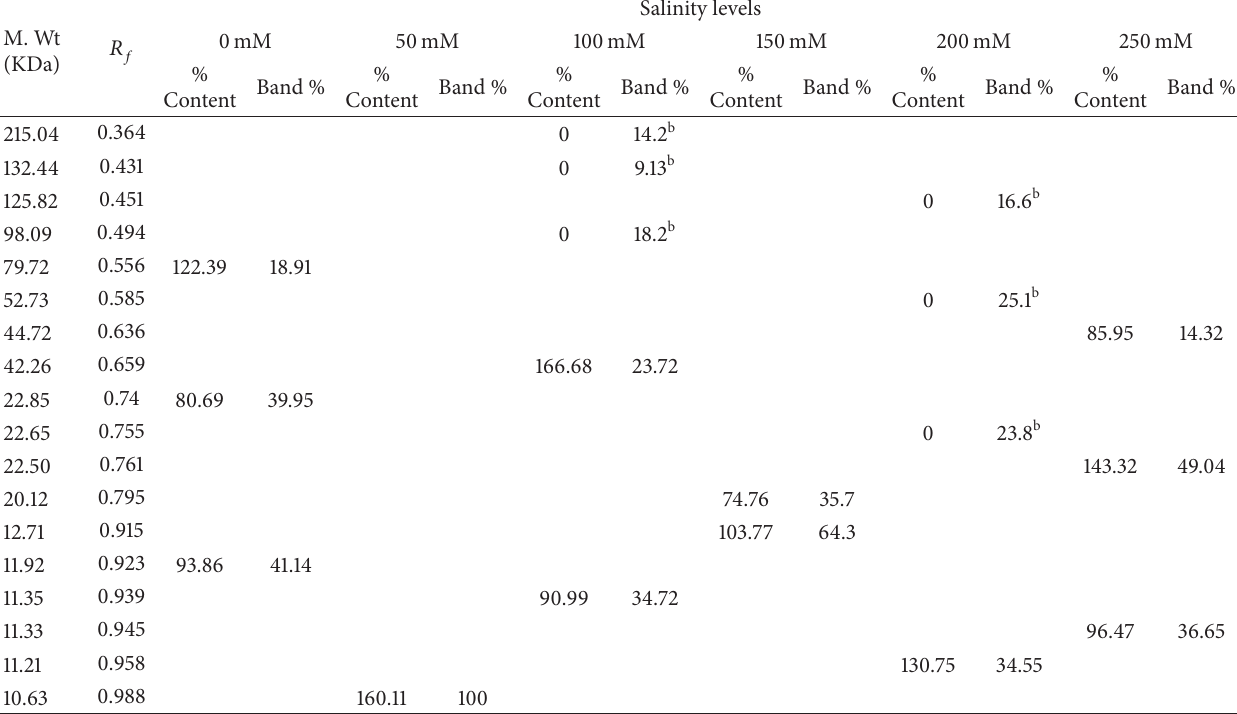
Table 2: Electrophoretic protein pattern of salinity stressed Triticum aestivum seedlings presoaked in 1% Ulva lactuca extract.